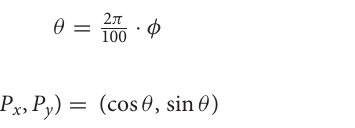
refers to the percentage of the gait cycle, representing the user’s walking progression between the heel-strikes, where φ ∈ [0,